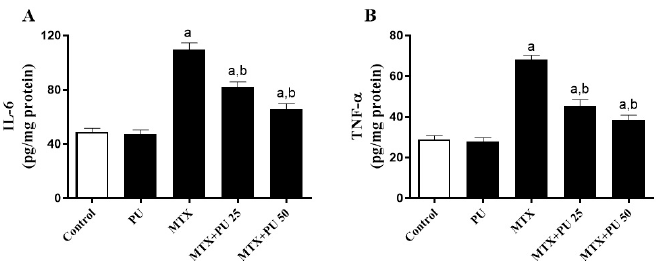
Figure 5. PU reduces hepatic ( A ) IL-6 and ( B ) TNF- α in MTX-injected mice. Results are expressed as mean ± SEM, ( n = 6). a indicates significant ( p < 0.05) vs. control, while b indicates significant ( p < 0.05) vs. MTX.